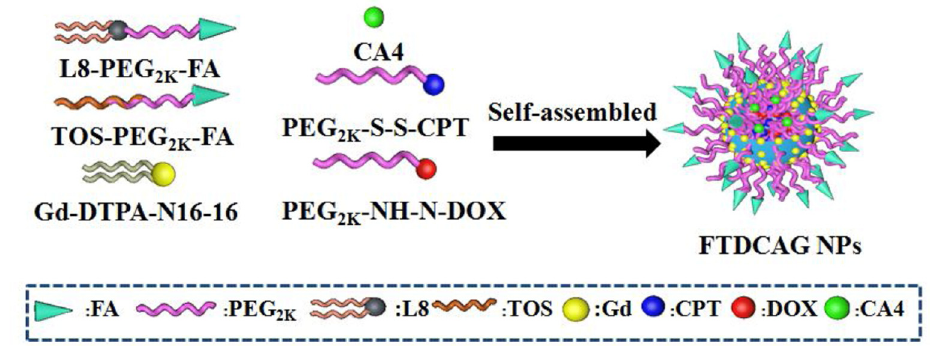
Figure 13. A schematic illustration of the configuration of the nanocarrier, based on double sensitive polymers with NH-H bonds and S-S bonds [121]. Reprinted from Colloids and Surfaces B: Biointerfaces, 205, N. Wang et al., A Traceable, GSH/PH Dual-Responsive Nanoparticles with Spatiotemporally Controlled Multiple Drugs Release Ability to Enhance Antitumor Efficacy, 111866, Copyright (2021), with permission from Elsevier.